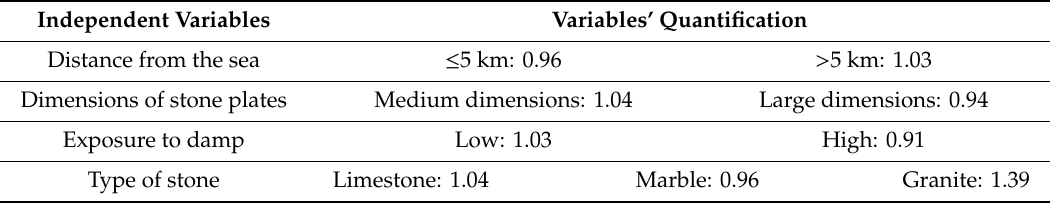
Table 4. Numerical quantification of the variables of the multiparameter deterministic model.